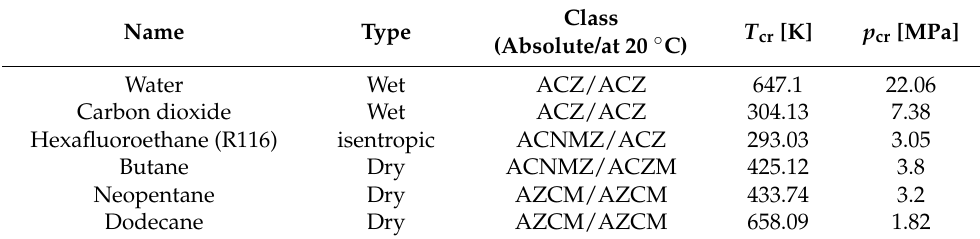
Table 1. Working fluids used in this study with some of their relevant